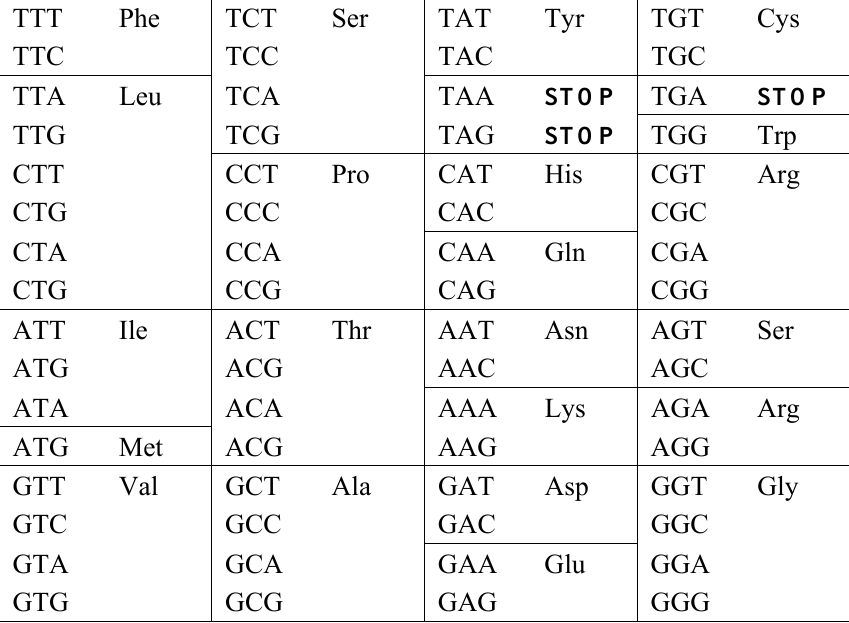
Table 2 . Trinucleotide codons and translation into amino